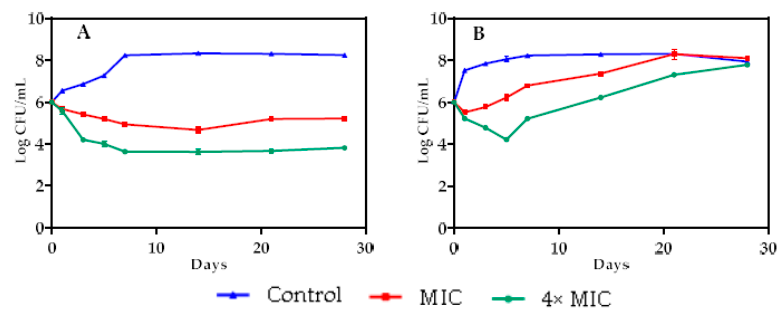
Figure 5. E ff ect of MIC and 4 × MIC of Achillea odorata subsp. pectinata essential oil on Proteus mirabilis Figure 5. Effect of MIC and 4× MIC of Achillea odorata subsp . pectinata essential oil on Proteus mirabilis ( A ) and Bacillus subtilis ( B ) in cabbage food system. ( A ) and Bacillus subtilis ( B ) in cabbage food system.